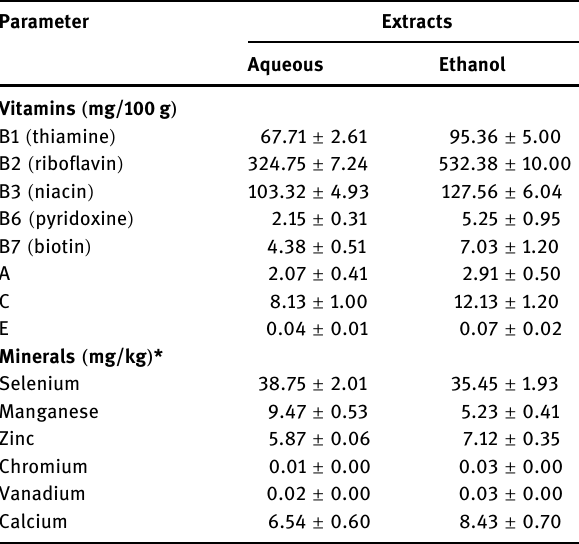
Table 2: Vitamin and mineral compositions of D. guineense stem bark extracts